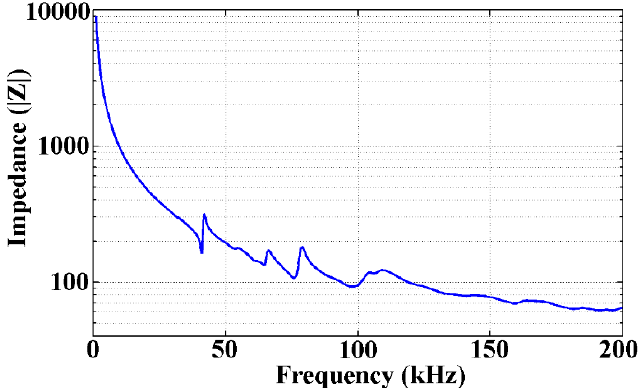
Figure 7. The experimental result of impedance analysis of the TSA.